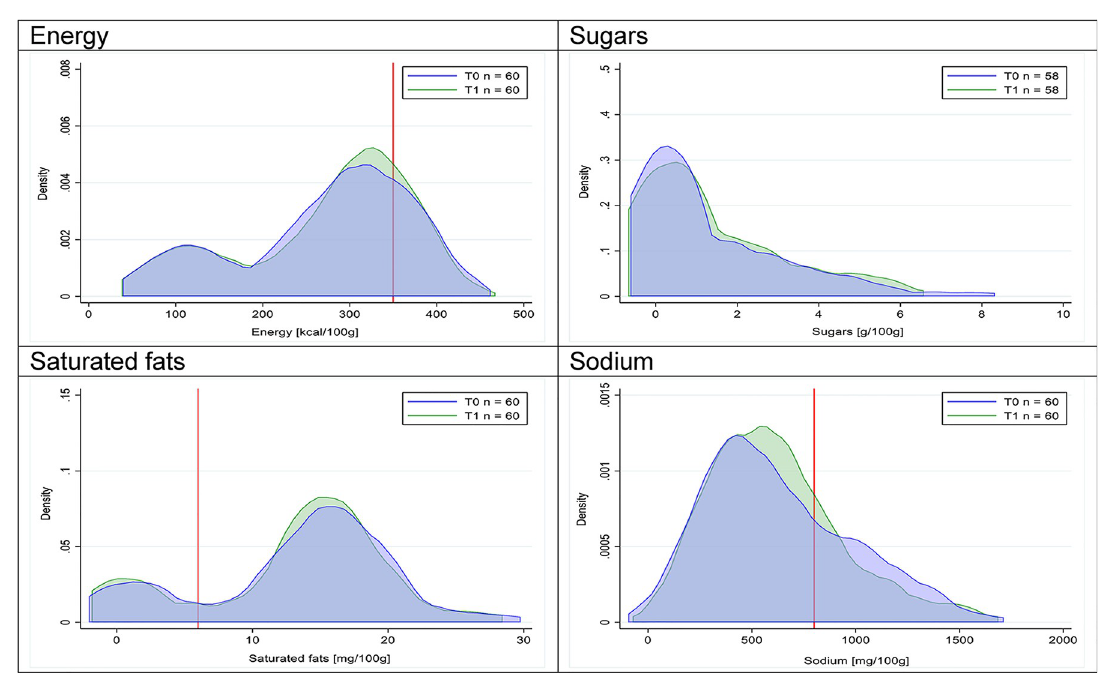
Fig 29. Density curves for the amount of energy and nutrients of concern in cheeses, longitudinal subsample. The blue line represents the distribution in T0 (preimplementation), the green line represents the distribution in T1 (postimplementation), and the red line represents the cutoff for the amount of energy or nutrients of concern.